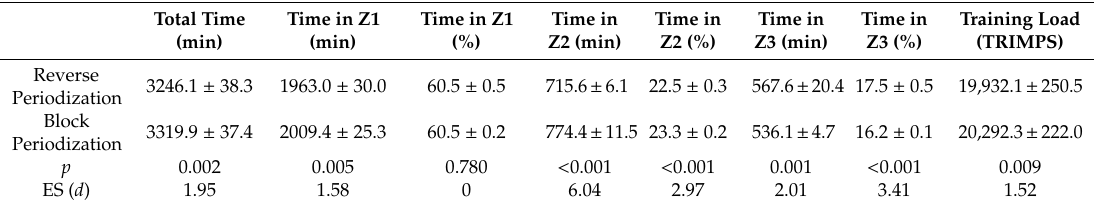
Table 5. Training load of each periodization group.